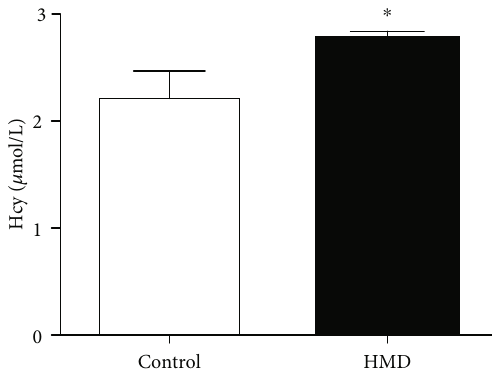
Figure 11: E ff ect of HMD on Hcy levels in serum of mice. (a) The Hcy levels in serum of mice. Note: value was expressed as mean ± SEM ( n = 5 ). ∗ p < 0 : 05 vs. control